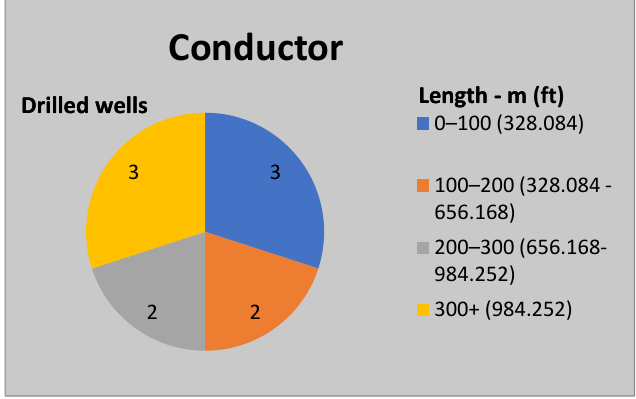
Figure 9. Setting depth of conductor strings installed in 10 analyzed wells.